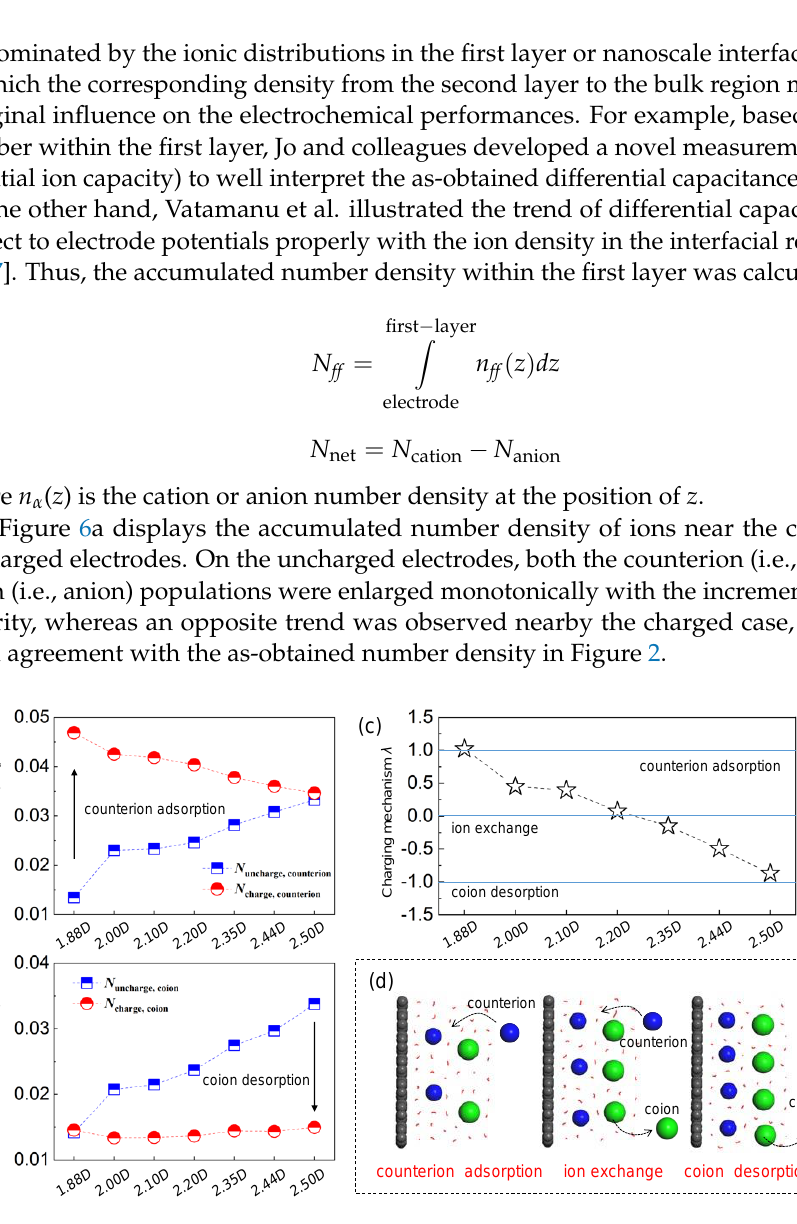
Figure 6. Accumulated number density for ( a ) counterions and ( b ) coions near the uncharged and charged graphene electrodes; ( c ) charging mechanism parameter λ as a function of solvent dipole moment; ( d ) schematic of charging mechanisms from counterion adsorption to coion desorption.